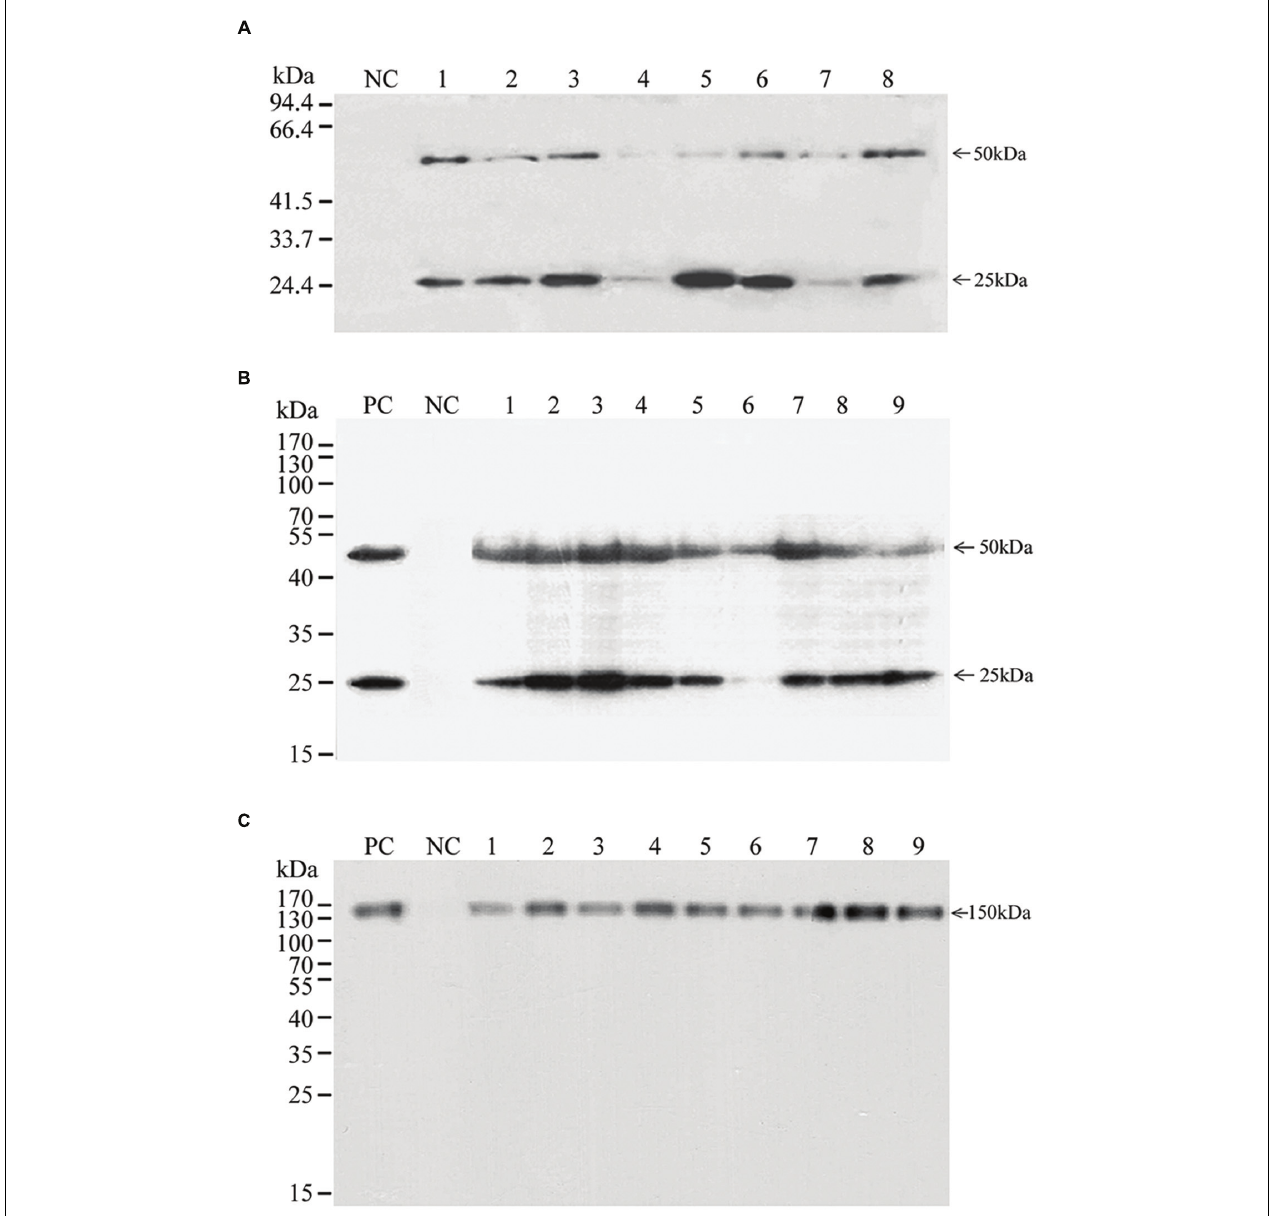
FIGURE 2 | Western blot of the expression of BHC, BLC, and Bevacizumab mAb in transgenic rice callus. The BLC, BHC, and Bevacizumab mAb were detected with a goat anti-human IgG (LC and HC) antibody under reducing (A,B) and non-reducing conditions (C) . (A) BHC and BLC were expressed from different gene expression cassette, (B,C) BHC and BLC were expressed as a polyprotein separated with the 2A peptide. PC is a positive control with a commercial Bevacizumab mAb; NC is a negative control with the total soluble proteins from non-transformed callus; lanes 1–8 in (A) , 1–5 and 6–9 in (B,C) are total soluble proteins from different transgenic events transformed with pUNBHLC, pUNBevaHL, and pUNBevaHL-KDEL, respectively. Protein molecular weights are indicated on the left side of each panel. BHC (50 kDa), BLC (25 kDa), and mAb (150 kDa) are indicated on the right side of each